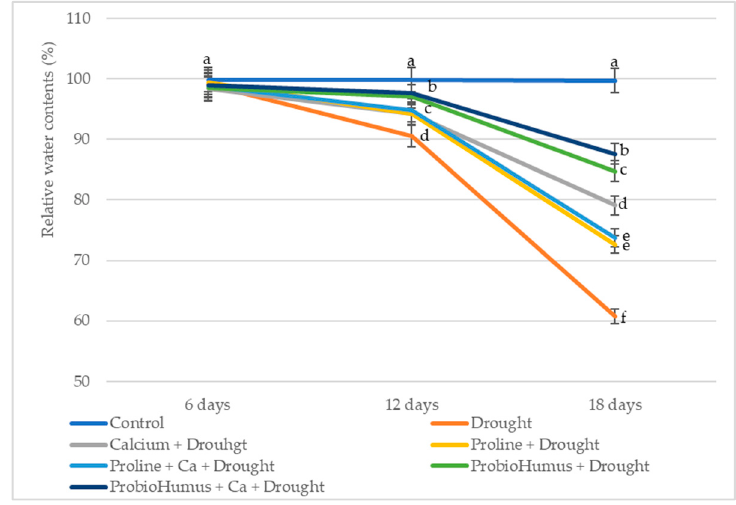
Figure 1. Impact of stress ‐ protecting compounds on RWC of winter wheat leaves after drought stress. Values reported are mean of thirty plant leaves with standard deviation. Means with different letters in the same day of drought are significantly different ( p < 0.05).